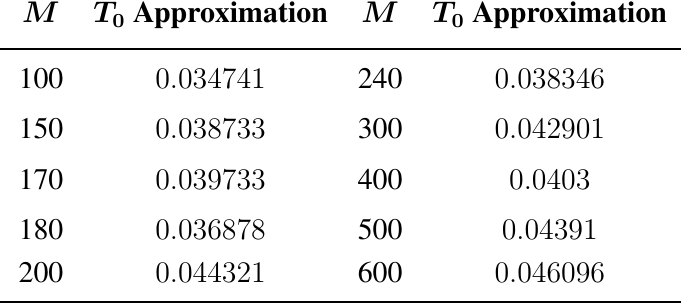
Table 8. Approximations of T (in ns) in the DDR4 module with a DRAM package 0 example using extrapolations of fitted quadratic error curves for various M . An estimate = 0 . 04 ns. The average time of the time delay obtained using alternative methods is T 0 delay obtained using various numbers of Fourier coefficients ranging from 100 to 600 is T ( aver ) = 0 . 040841 0